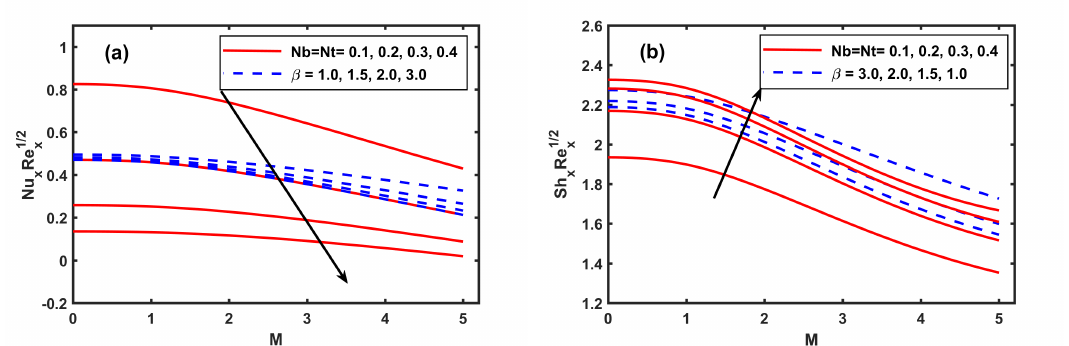
Figure 11. Fluctuation of Nu x Re 1/2 x and Sh x Re 1/2 x along with Nb, Nt, M, and β .